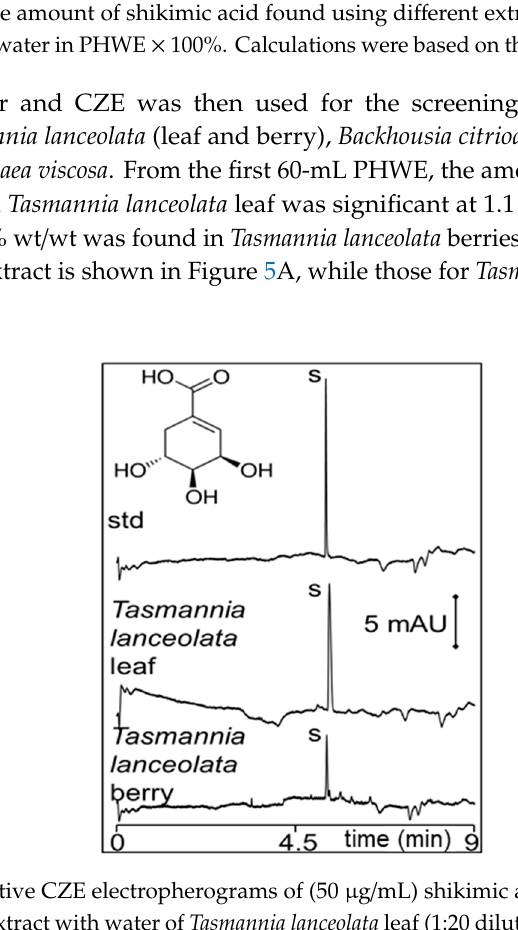
Figure 6. Representative CZE electropherograms of (50 µg/mL) shikimic acid in-house standard (std) and the first PHWE extract with water of Tasmannia lanceolata leaf (1:20 dilution) and berry (1:4 dilution). The extracts were diluted with water. Other conditions are in the Materials and Methods Section.